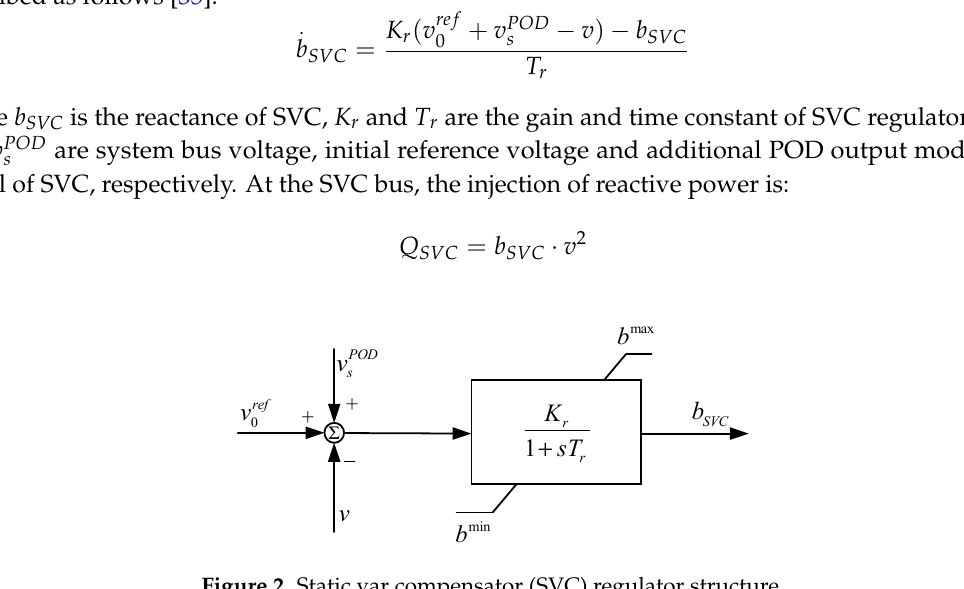
Figure 2. Static var compensator (SVC) regulator structure. Figure 2. S tatic var compensator (SVC) regulator structure.